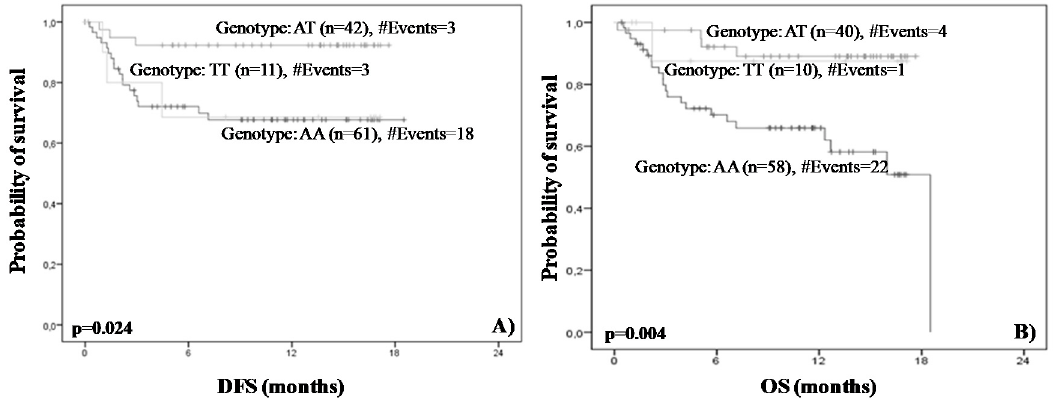
Figure 5. Kaplan–Meier disease-free ( A ) and overall ( B ) survival curves. p values were calculated by log-rank test. Table 3. Cox univariate regression analysis of rs822337 T>A for the prediction of disease-free (DFS) and Overall survival (OS).